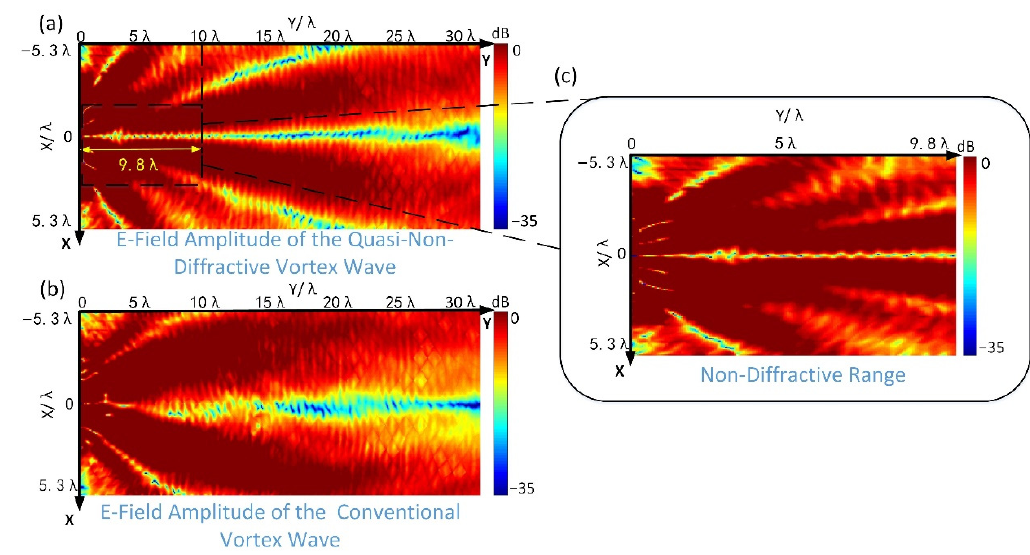
Figure 8. Simulated distributions of the E-field amplitude on the x–z planes for ( a ) the quasi-non-diffractive vortex wave and ( b ) conventional vortex wave, respectively. ( c ) A magnified view of the non-diffractive range.